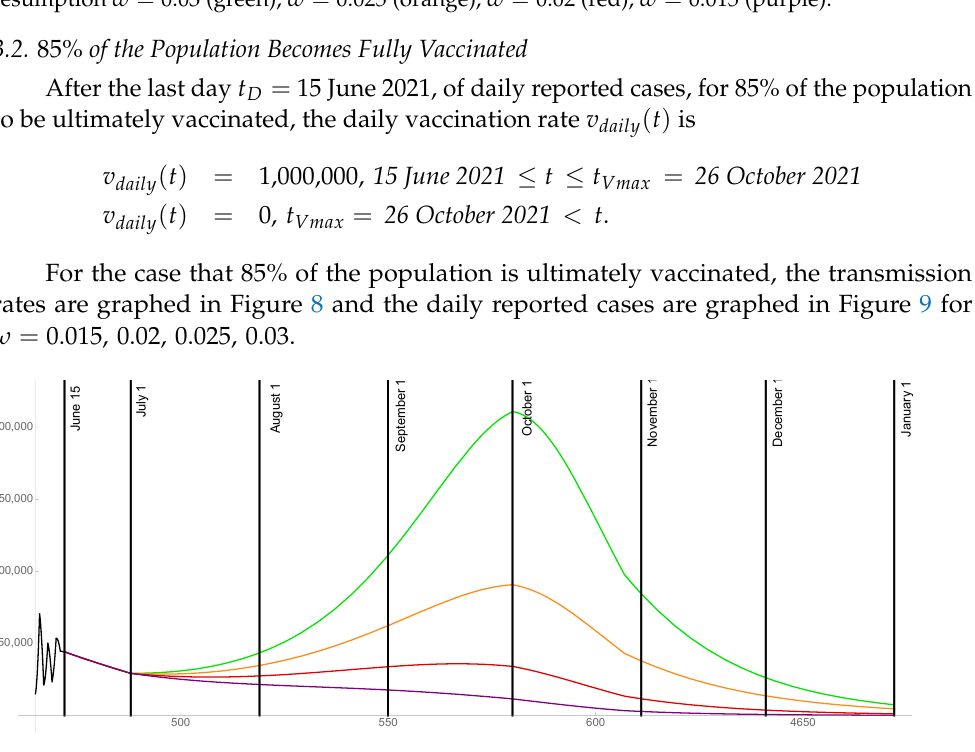
Figure 8. Transmission rates for the level of social distancing resumption ω = 0.03 (green), ω = 0.025 (orange), ω = 0.02 (red), ω = 0.015 (purple). The ultimate vaccinated population reaches 85%.